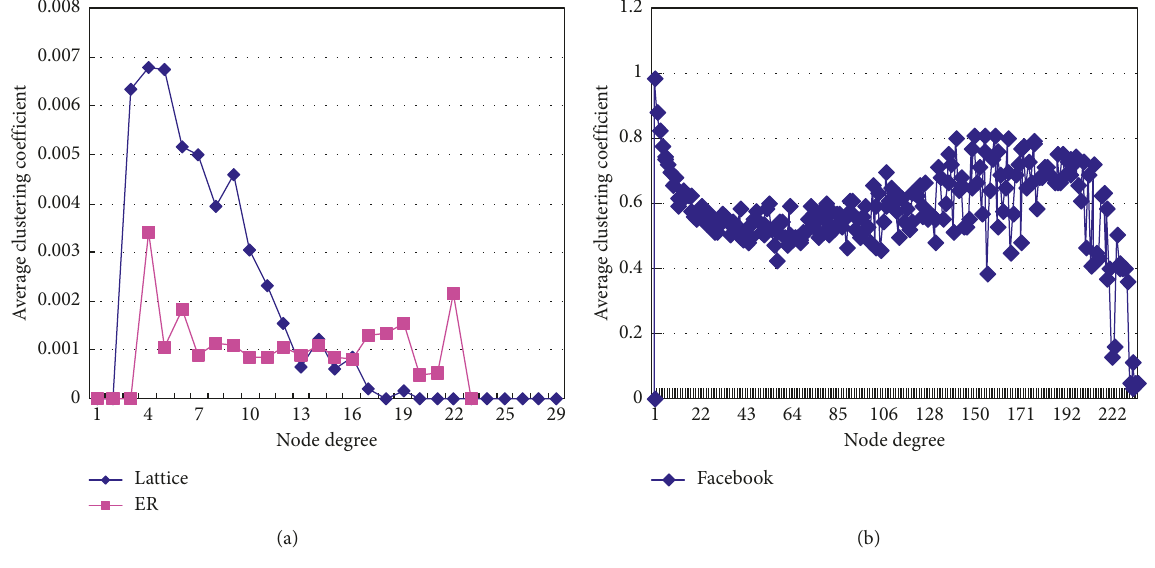
Figure 7: Clustering coefficient of three kinds of network structures. (a) Lattice and ER. (b) Facebook.